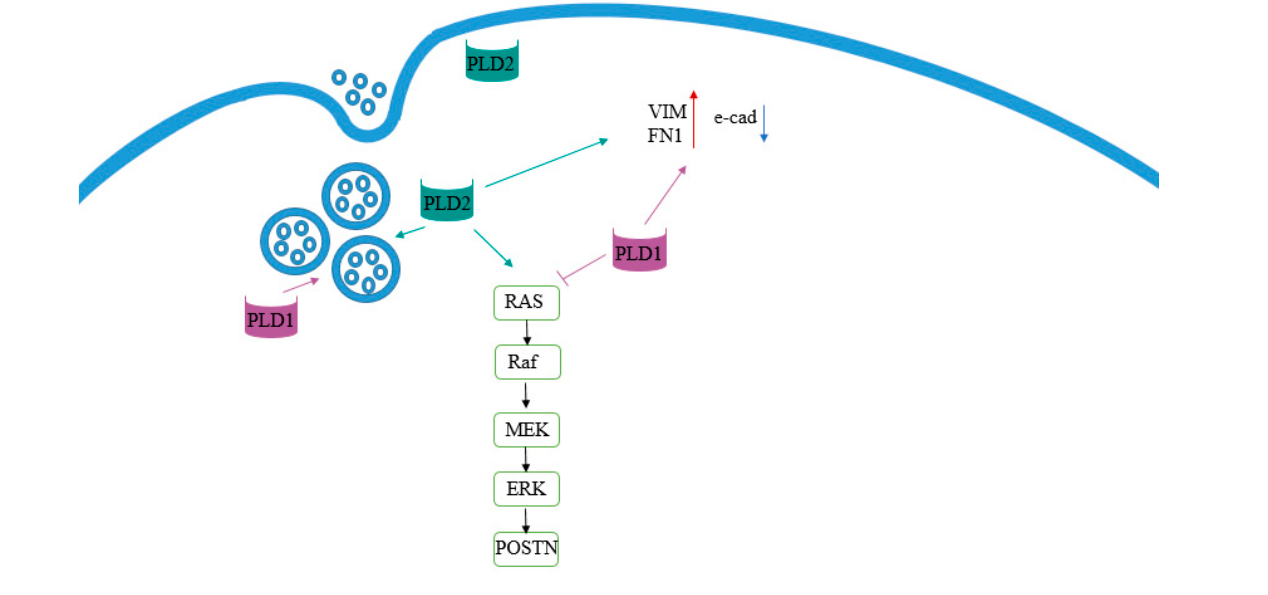
Figure 8. Suggested model for PLD signaling pathway.